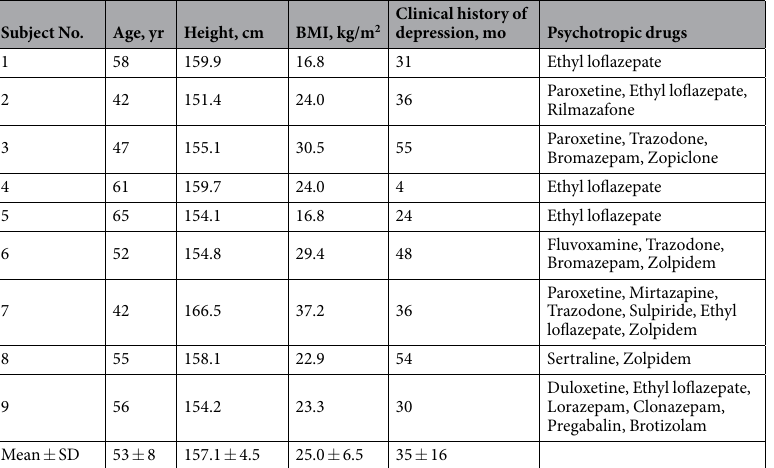
Table 1. Physical characteristics, clinical history, and current psychological drug used for therapy in individual subjects. BMI, body mass index.